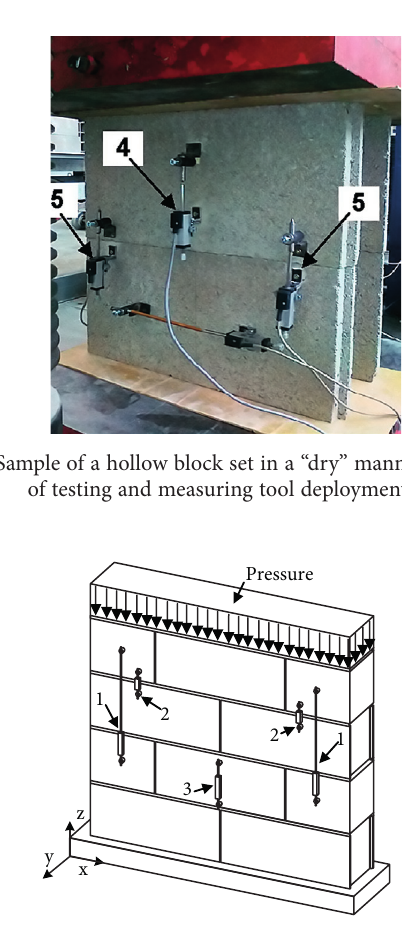
Fig. 5. Experimental scheme of masonry with filled hollows and tool deployment